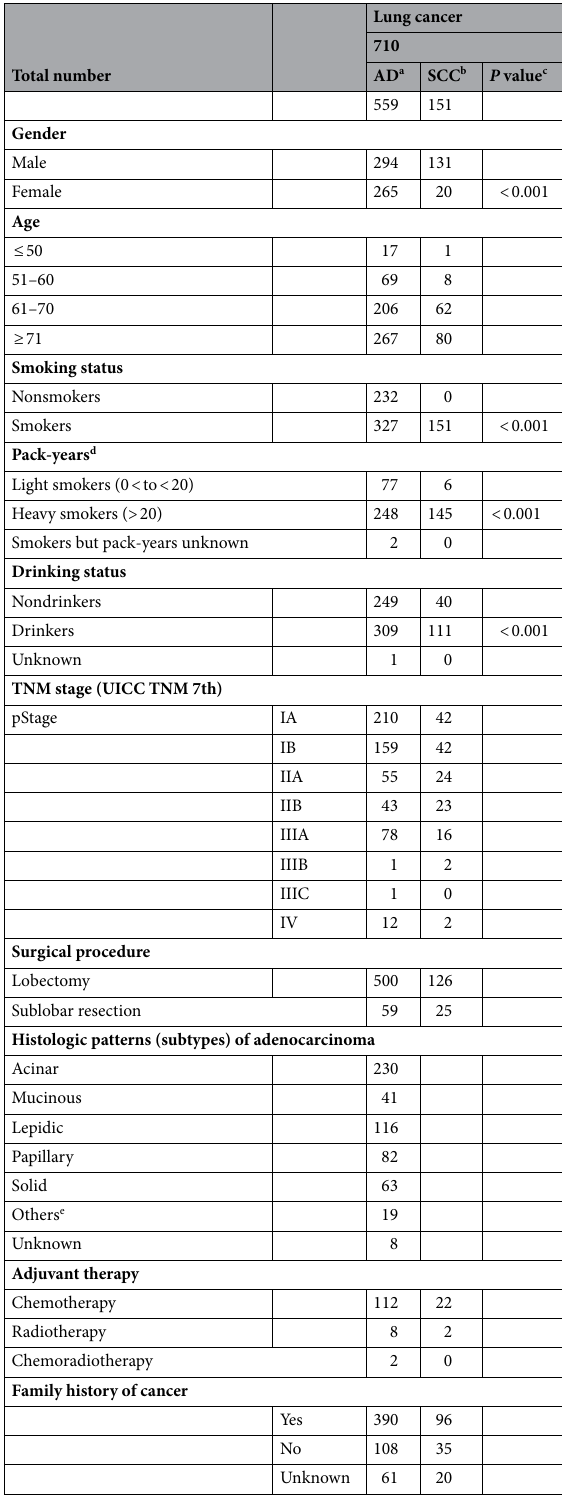
Table 2. Characteristics of the patients with lung cancer. a AD; Adenocarcinoma, b SCC; Squamous cell carcinoma, c P value by Fisher’s exact test, d Pack-years; defined as the number of packs of cigarettes amoked per day times of years of smoking, e Others were as follows: minimally invasive (n = 15), moderately differentiated (n = 1), poorly differentiated (n = 2), and pulmonary (n =